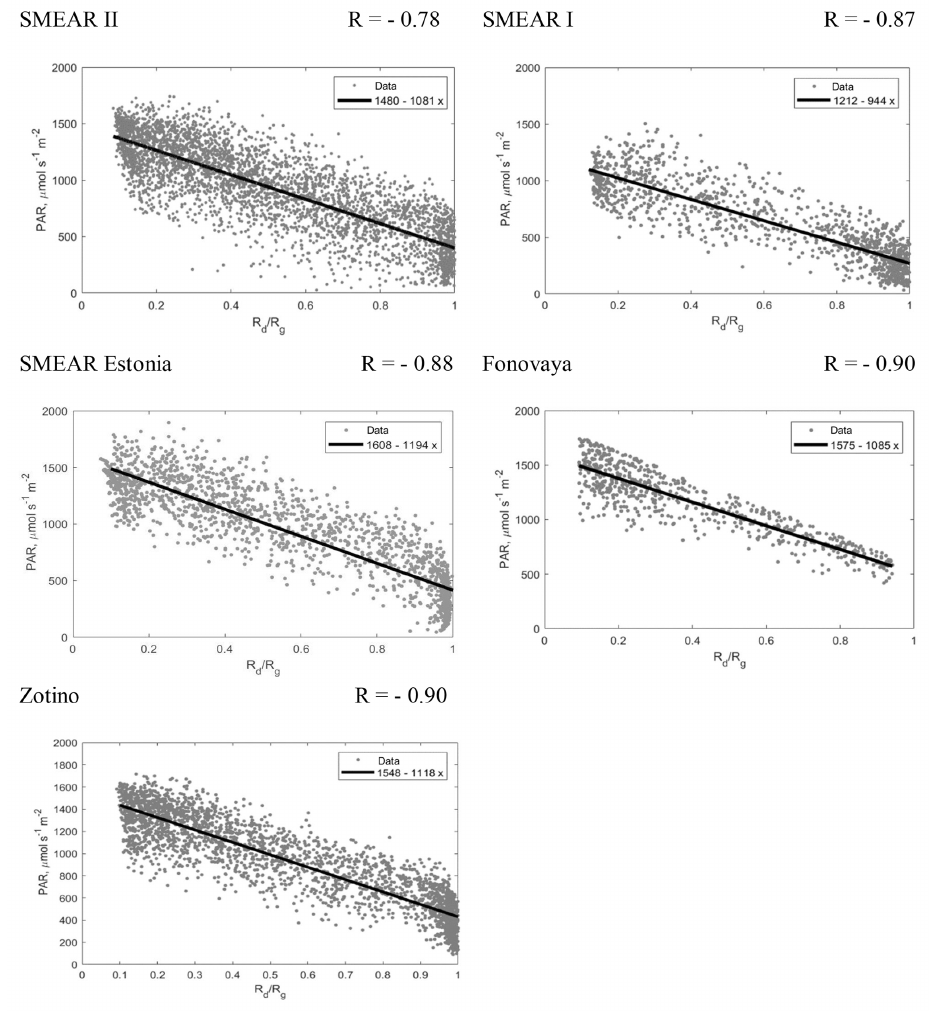
Figure 7. Photosynthetically active global radiation (PAR) as a function of the diffuse fraction of global irradiance ( R d /R g ). All dependences are statistically significant ( p < 0 . 001). The number of sample points is reported in the caption of Fig.